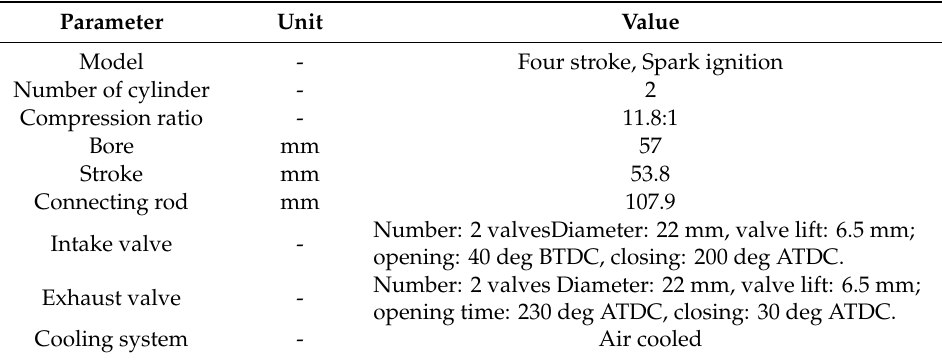
Table 1. Specifications of the researching engine